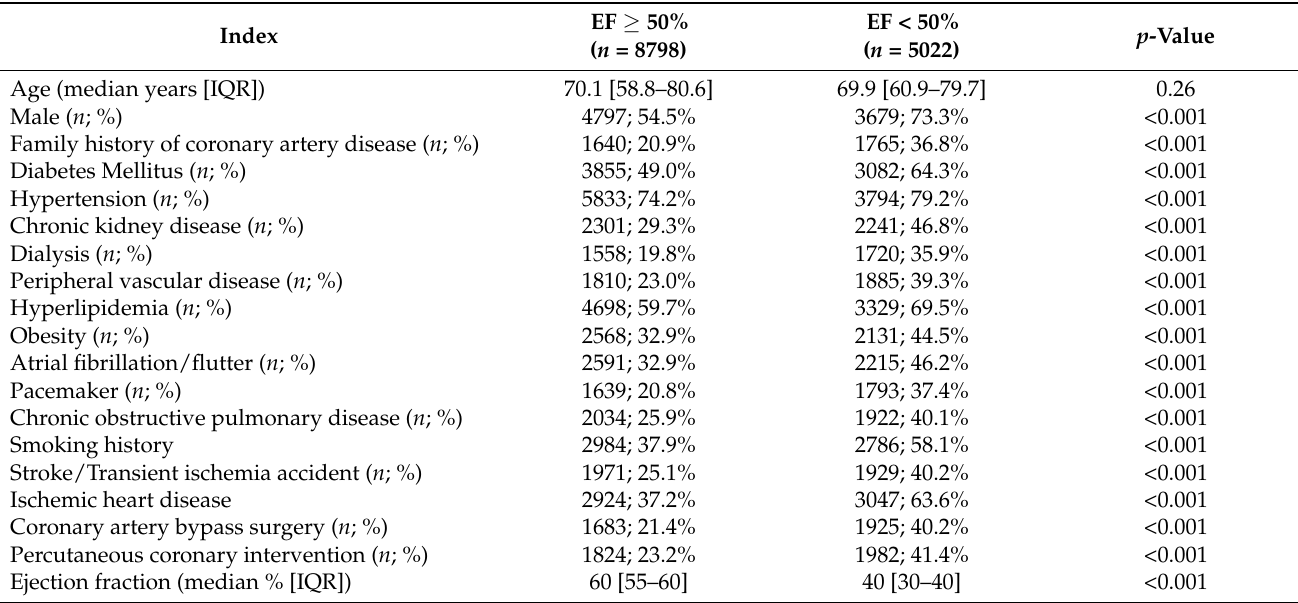
Table 2. Baseline characteristics of patients with normal ejection fraction (EF ≥ 50%) and abnormal ejection